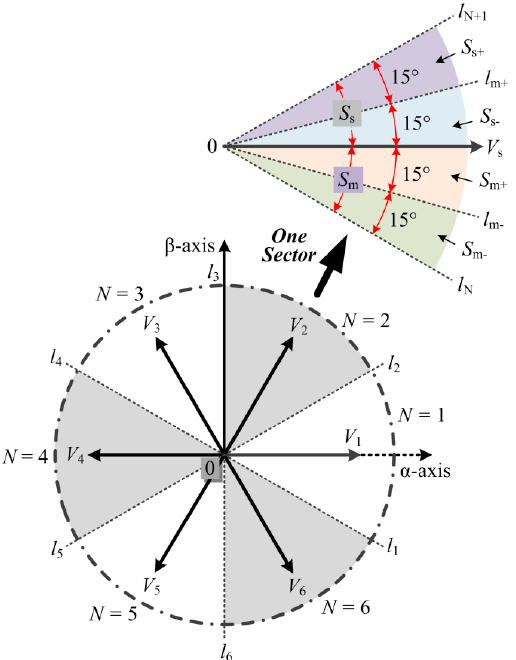
Figure 11. Relationships of the variables in the control system.